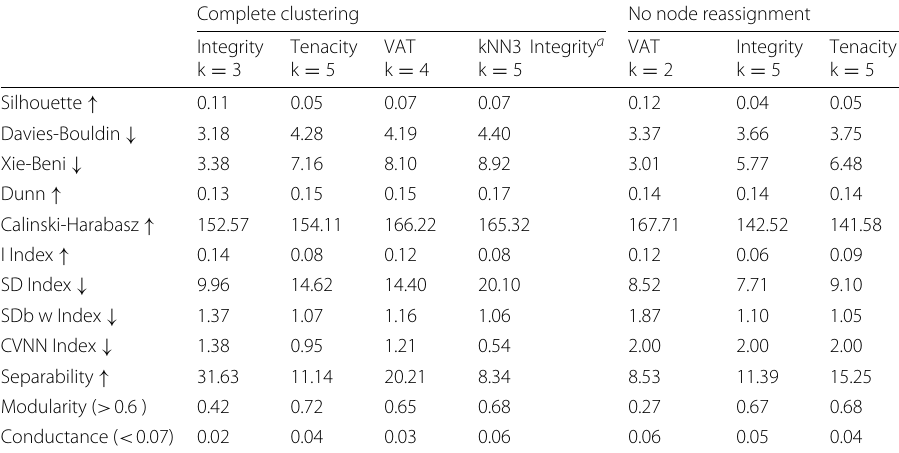
Table 3 Optimal Cluster configuration by graph type and resilience measures Complete